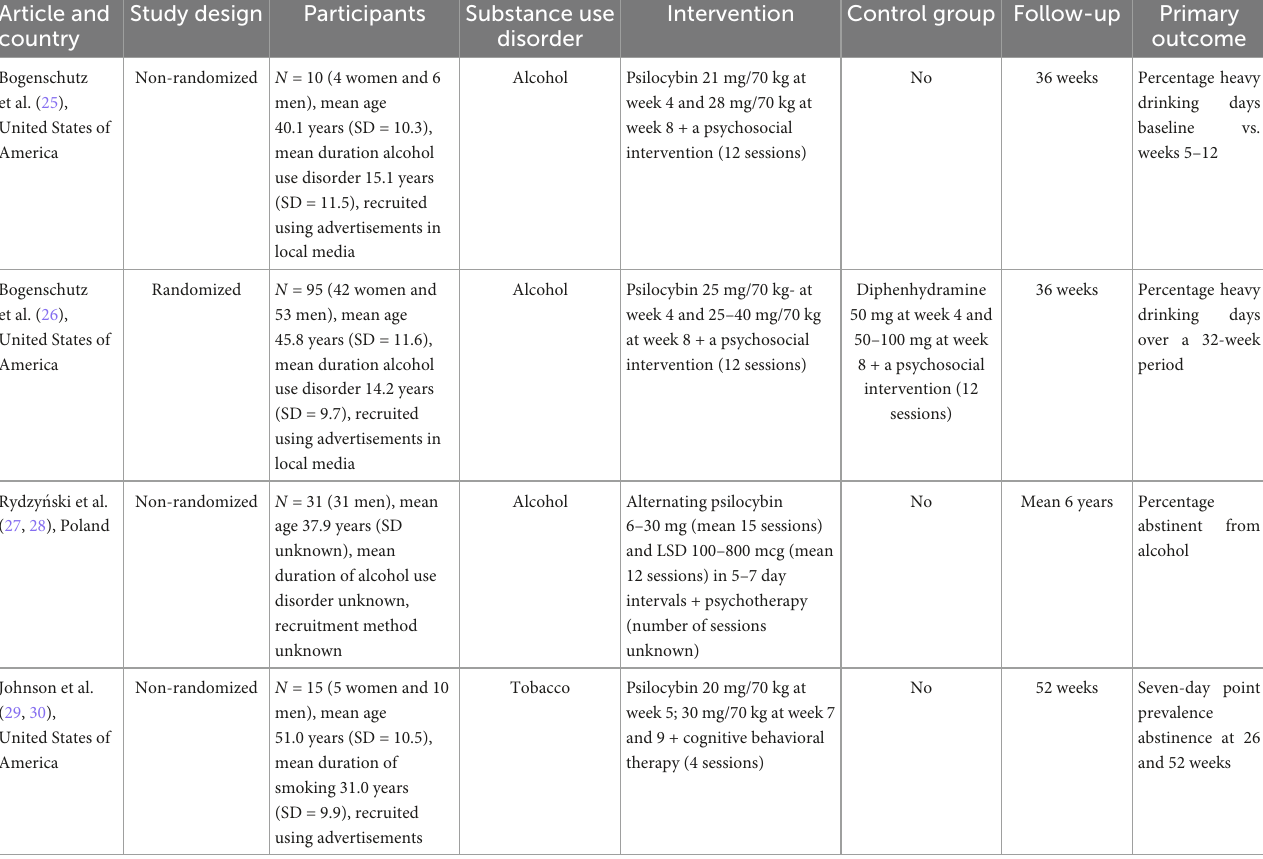
TABLE 1 Clinical trials evaluating the efficacy of psilocybin in substance-use